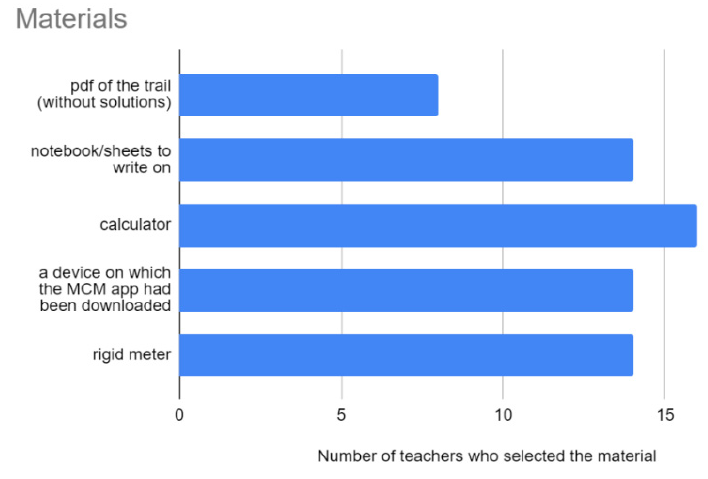
Figure 9. Materials used during the math trail.